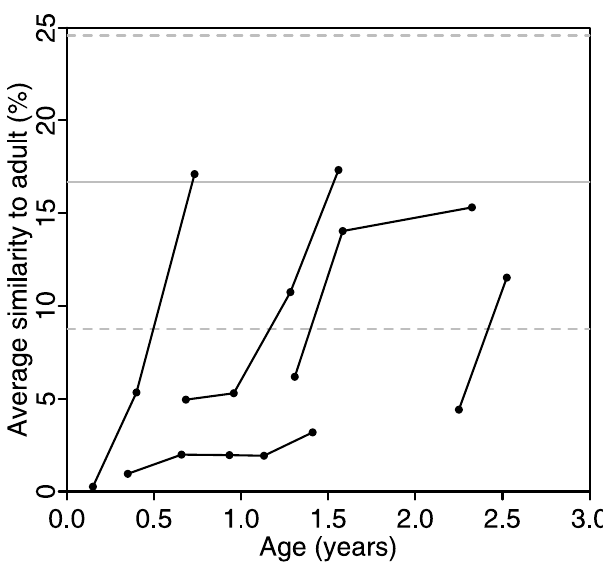
Fig 2. Microbiomes of healthy young children increase in similarity to adults in the first three years. Gut microbiomes of healthy young children serving as controls in a CF study were compared with adult microbiomes from the HMP. The median microbiome similarity (points) for young children compared with a random selection of twenty adults are shown for longitudinal samples (connected by lines) for five young children. The average (solid horizontal line) and first standard deviation (dashed lines) were derived from the 100 adult samples (50 independent pairs).